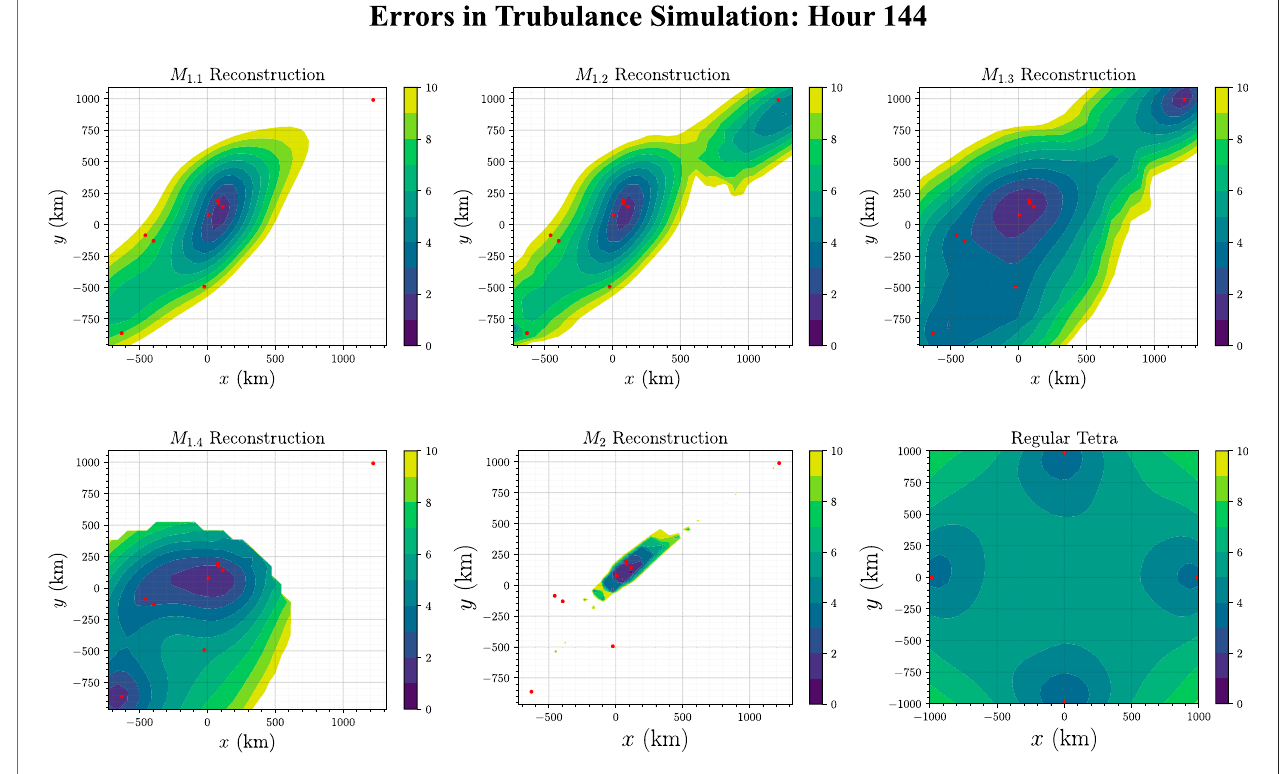
FIGURE 9 | Computation error (de fi ned in Eq. 7 ) at all points on the z (cid:1) 0 plane of the turbulent magnetic fi eld (from the Gkeyll Simulation), using the swarm con fi guration at hour 144 of the HelioSwarm DRM. The layout is identical to Figure 4